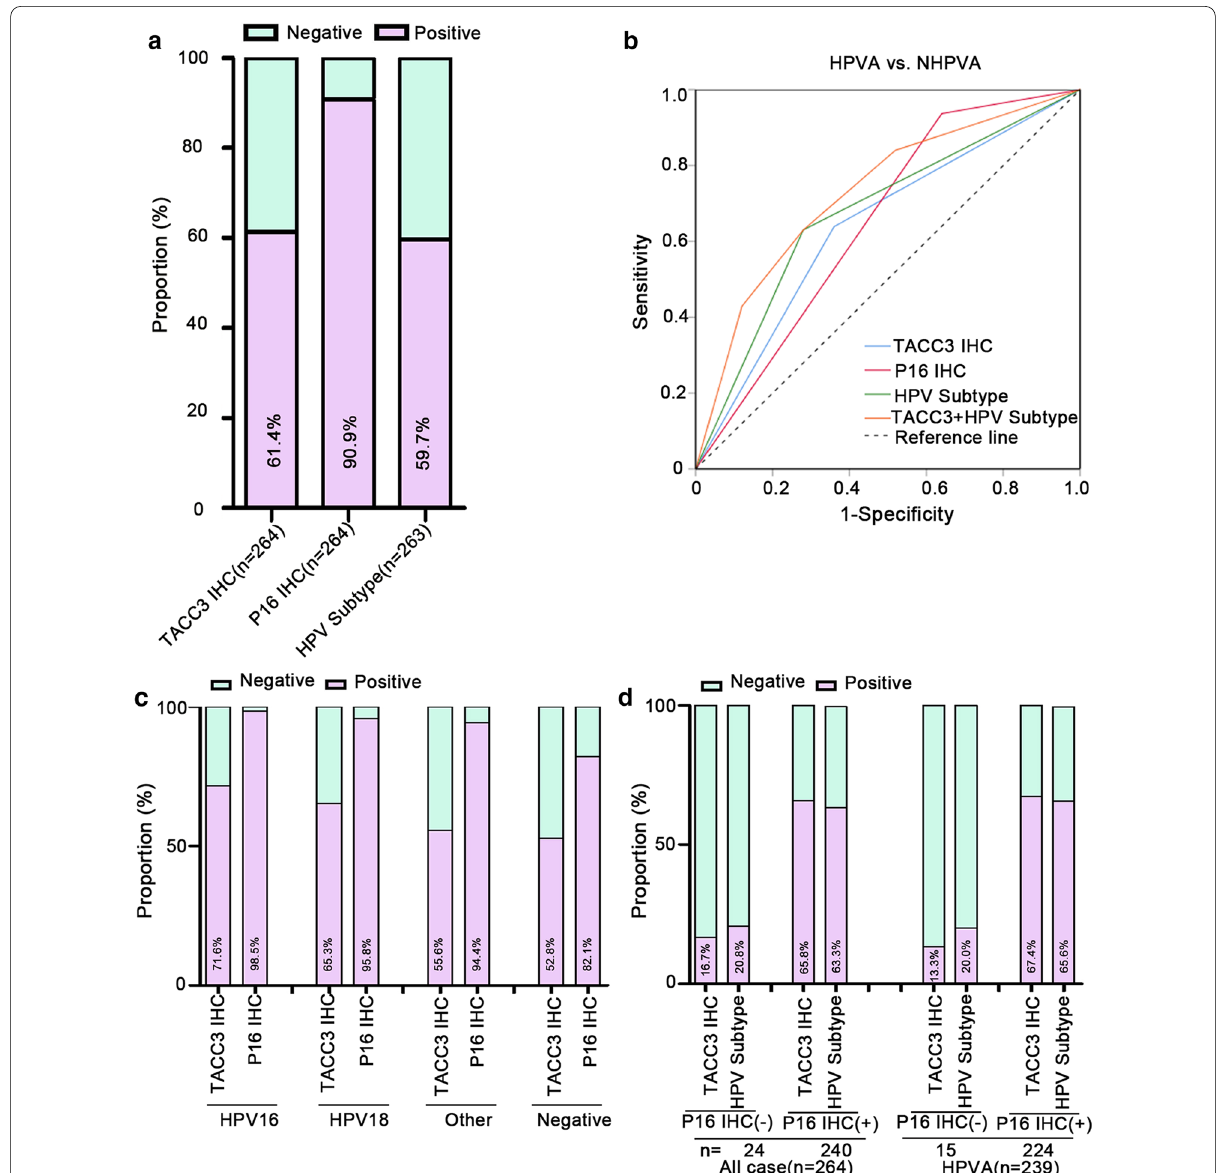
Fig. 5 Diagnostic performance of tests for patients with endocervical adenocarcinoma (ECA). a Positive rates of TACC3, P16, and HPV subtypes in ECA cases. b ROC curve analyses of TACC3, P16, HPV subtypes, and the panel of TACC3 cases with different HPV subtypes. d Positive rates of TACC3 and HPV subtypes in patients with ECA in P16‑negative and P16‑positive subgroups. TACC3 immunohistochemistry (IHC), TACC3 protein detected by IHC; P16 IHC, P16 protein detected by IHC; HPV subtypes, HPV subtypes detected by